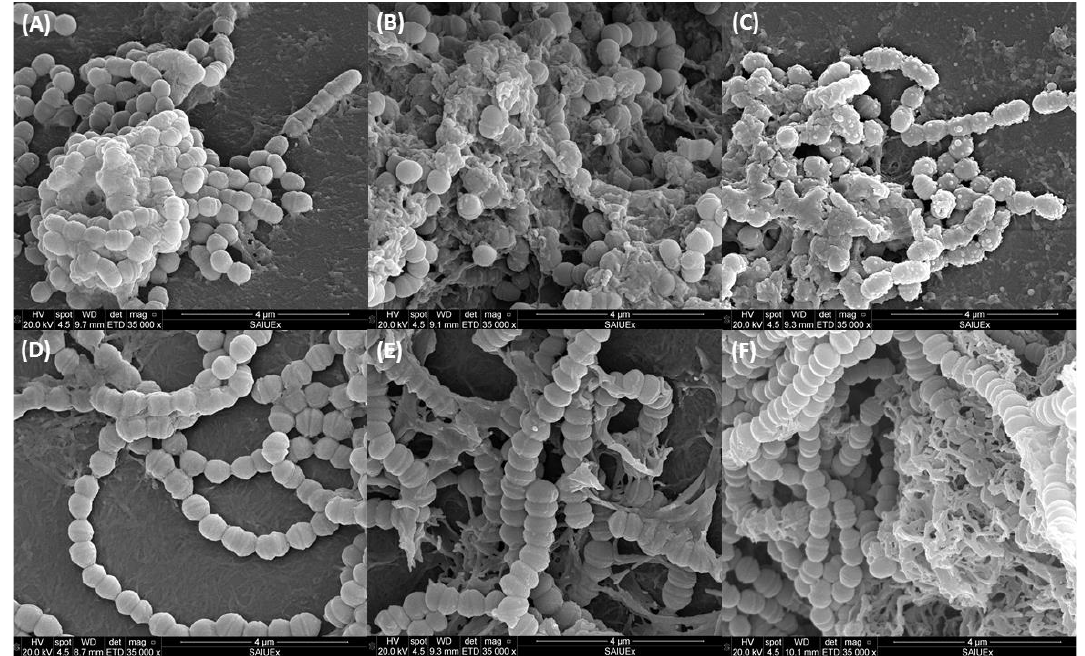
Figure 5. Image obtained by scanning electron microscopy of the biofilm generated by S. mutans ( above ) and S. sanguinis ( below ) at two different concentrations of CAR (( A , D ): Control; ( B , E ): 1.5 mg/mL (1.5%), ( C , F ): 11.95 mg/mL(12.5%)).